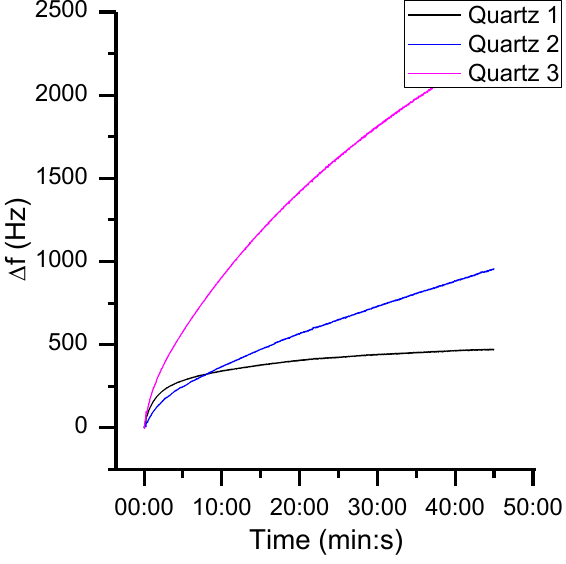
Figure 15. Frequency response upon warm-up with a constant air stream of 1,000 sccm.